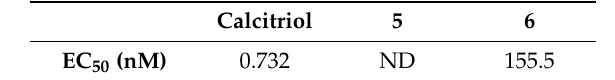
Table 2. Induction of CD14 expression by calcitriol and analogs a .